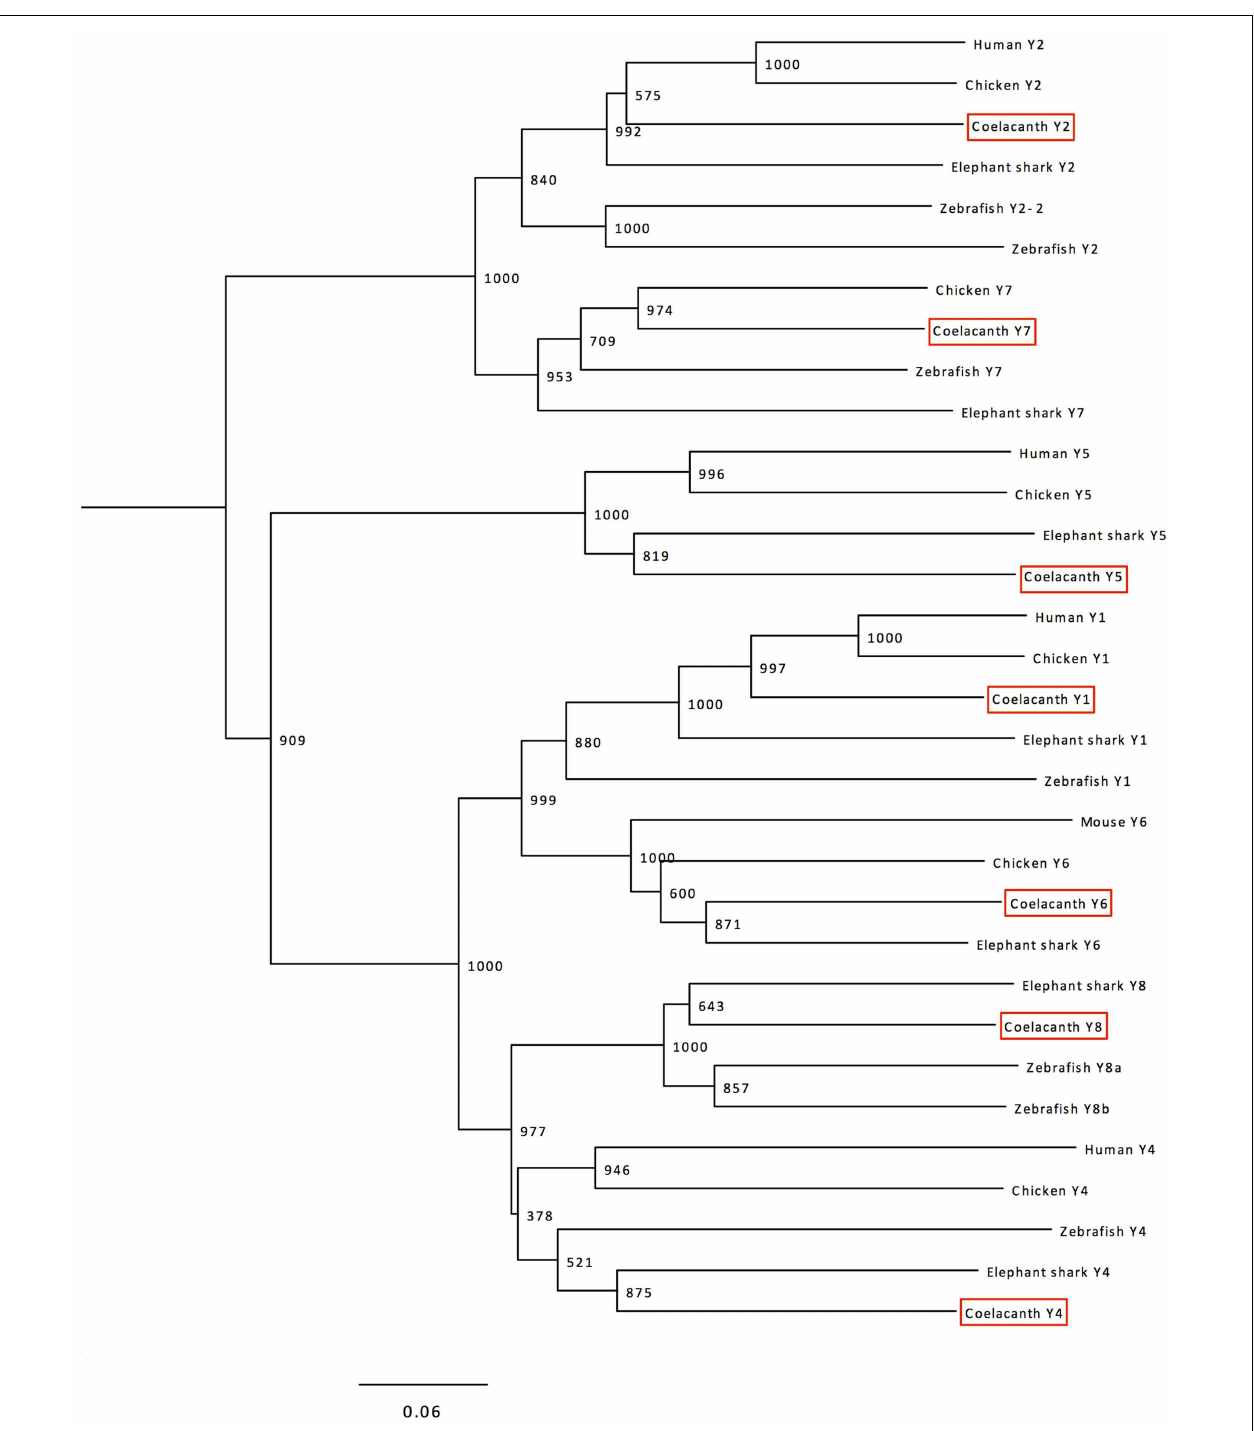
FIGURE 2 | Phylogenetic tree calculated with the Neighbor-Joining method showing the relationships of the NPY-family receptor sequences in coelacanth, human (exceptY6 where the mouse sequence is included instead of the human pseudogene), chicken, zebrafish, and elephant shark. The human somatostatin receptor 1 (SSTR1) was used as outgroup to